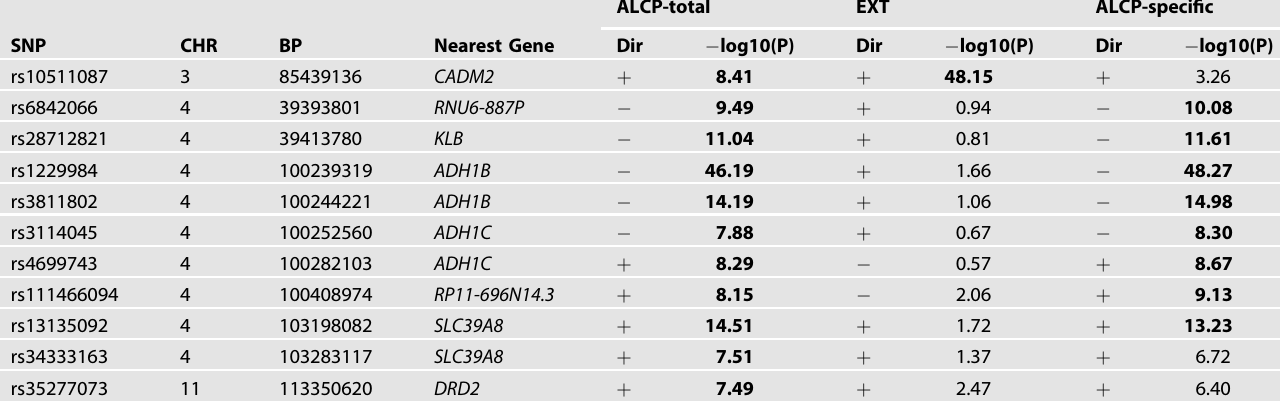
Table 1. ALCP-total Lead SNPs across ALCP-total, EXT, and ALCP-speci fi c